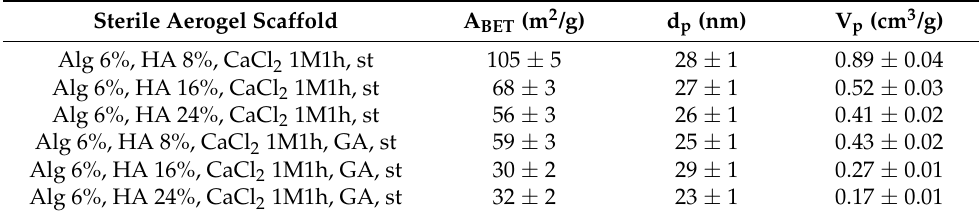
Table 4. Textural properties of sterile aerogel-based scaffolds obtained from aqueous 6 wt.% alginate inks with different HA contents (0, 8, 16, 24 wt.%) and crosslinked by ageing with CaCl 2 1M1h and by GA. Notation: A BET : specific BET surface area, d p : BJH-mean pore diameter, V p : BJH-specific pore